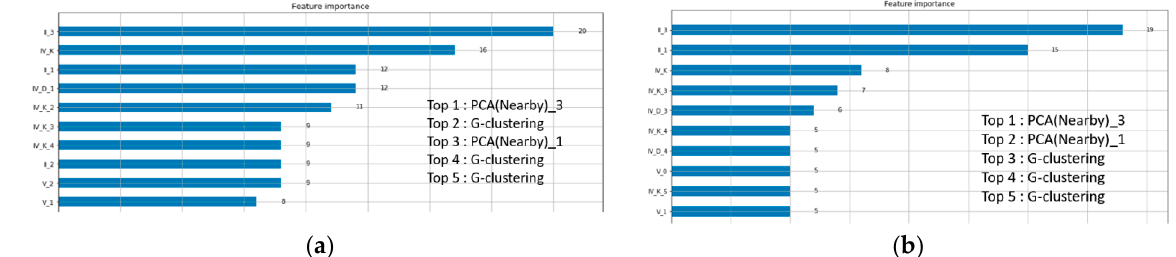
Figure 10. Feature importance of Batch 2. ( a ) Represents rental demand, and ( b ) represents the drop-off one.